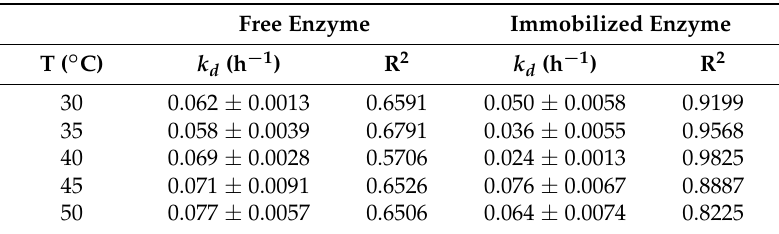
Table 1. Thermal denaturation kinetic parameters for free and immobilized lipase. Free